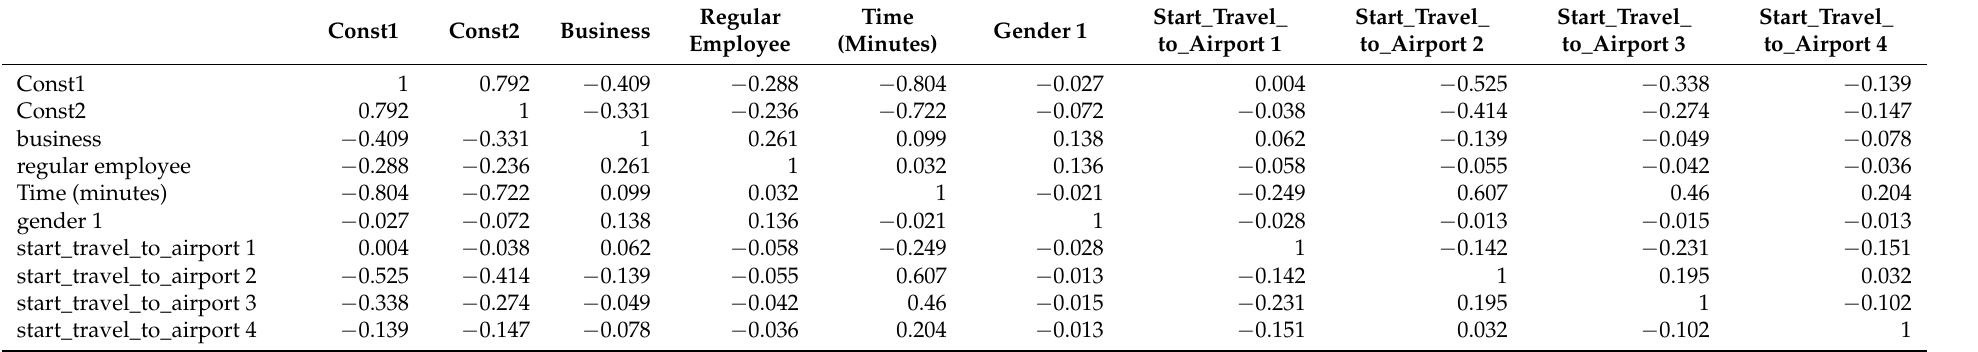
Table A1. Correlation matrix for the ordered logit (dependent variable: assessing the travel time).